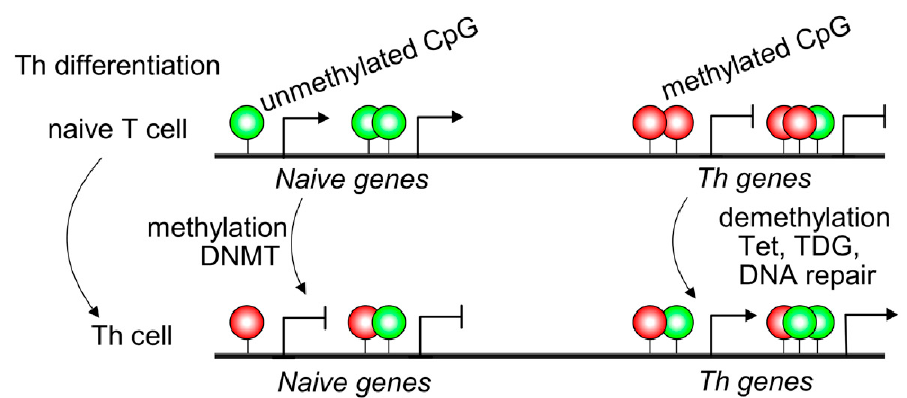
Figure 1. Methylation dynamics during Th differentiation. Naïve T cells display unmethylated and methylated cytosines on CCGG sites (CpG as green circles and mCpG as red circles), leading to gene expression (arrows) and repression (scale lines), respectively. During Th differentiation, dynamic control and remodeling on specific CpG sites occur. Genes linked to Naïve T cell biology may be repressed by several mechanisms, including DNA methylation on its CpG sites by methylases enzymes, such as DNA methyltransferases (DNMTs). By contrast, repressed Th genes on naïve T cells are induced under T cell priming conditions. These Th genes need to be demethylated by a group of enzymes which Tet2/3 are the most important converting methyl-C in hydroxymethyl-C. Then, this hydroxymethyl-C suffers serial reactions to result in C by DNA repair enzymes.